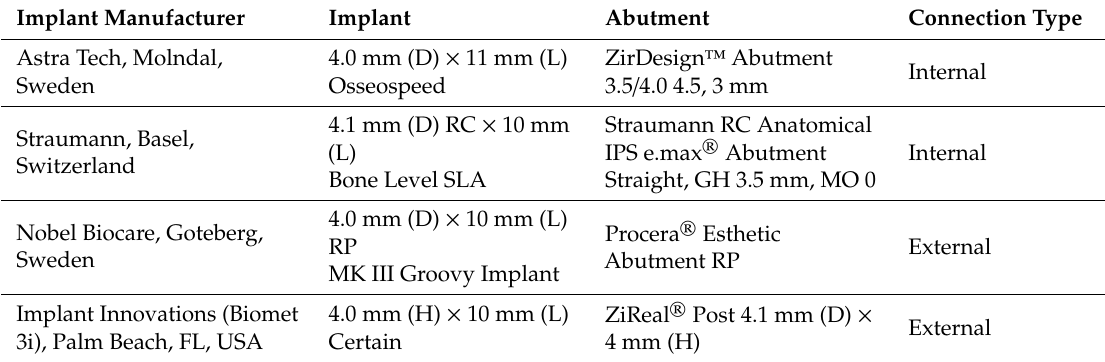
Table 1. Types of implant assembly used in this